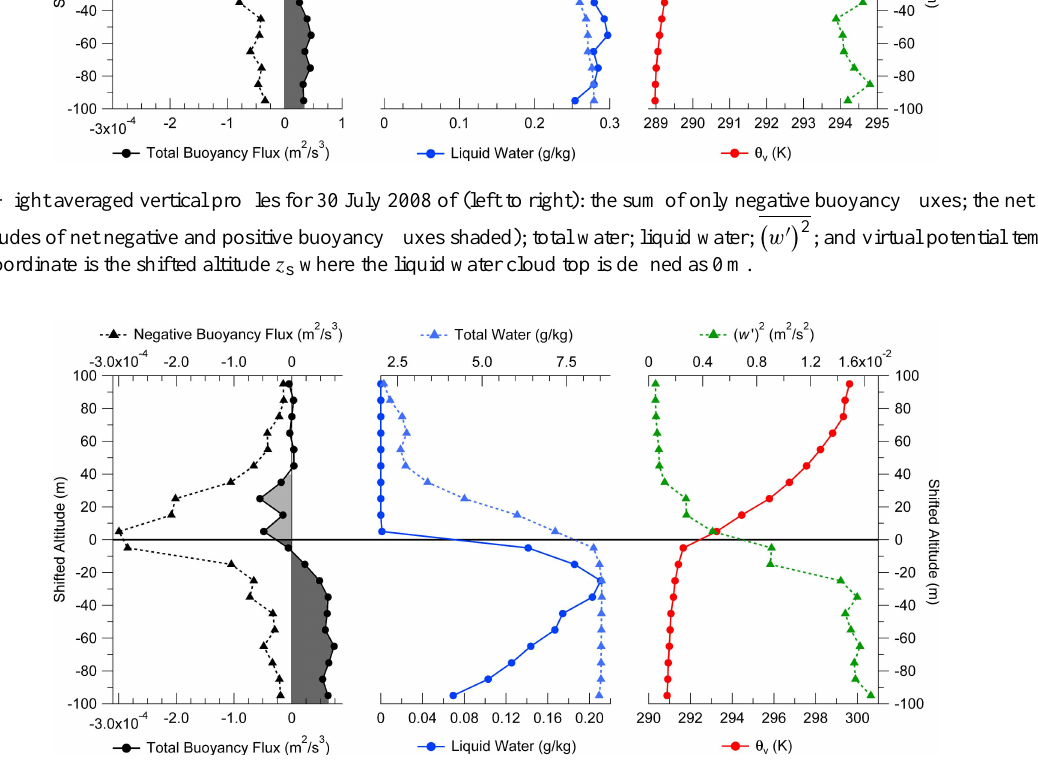
Fig. 5. Whole-flight averaged vertical profiles for August 6, 2008 of (left to right): the sum of only negative buoyancy fluxes; the net buoyancy flux (with altitudes of net negative and positive buoyancy fluxes shaded); total water; liquid water; (cid:0) w 0 (cid:1) 2 ; and virtual potential temperature. The vertical coordinate is the shifted altitude z s where the liquid water cloud top is defined as